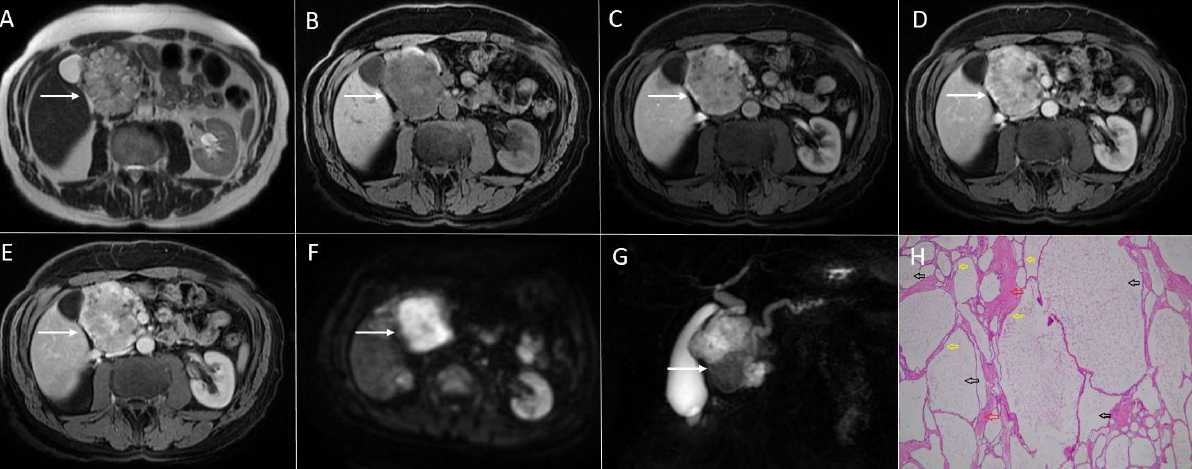
Figure 11. Serous cystadenoma in 68-year-old men. On T2-weighted image ( A ), a lobulated hyper- intense lesion ( arrow ) is seen in the pancreatic head. Note fibrous scar in the center of the lesion. The lesion ( arrow ) is hypointense on T1-weighted image ( B ) with slight enhancement in arterial phase ( C ) and progressive enhancement in portal-venous ( D ) and delayed phase ( E ). On DWI ( F ), the lesion has high signal intensity. MRCP ( G ) nicely depicts microcystic nature of the lesion. Hematoxylin and eosin (H&E) staining ( H ) showed multiple microcystic spaces lined with single row cubic epithelium ( black arrows ), and small uniform nuclei without atypical features ( yellow arrows ). Fibro-sclerotic septas between small cysts are also shown ( red arrows ); original magnification ×